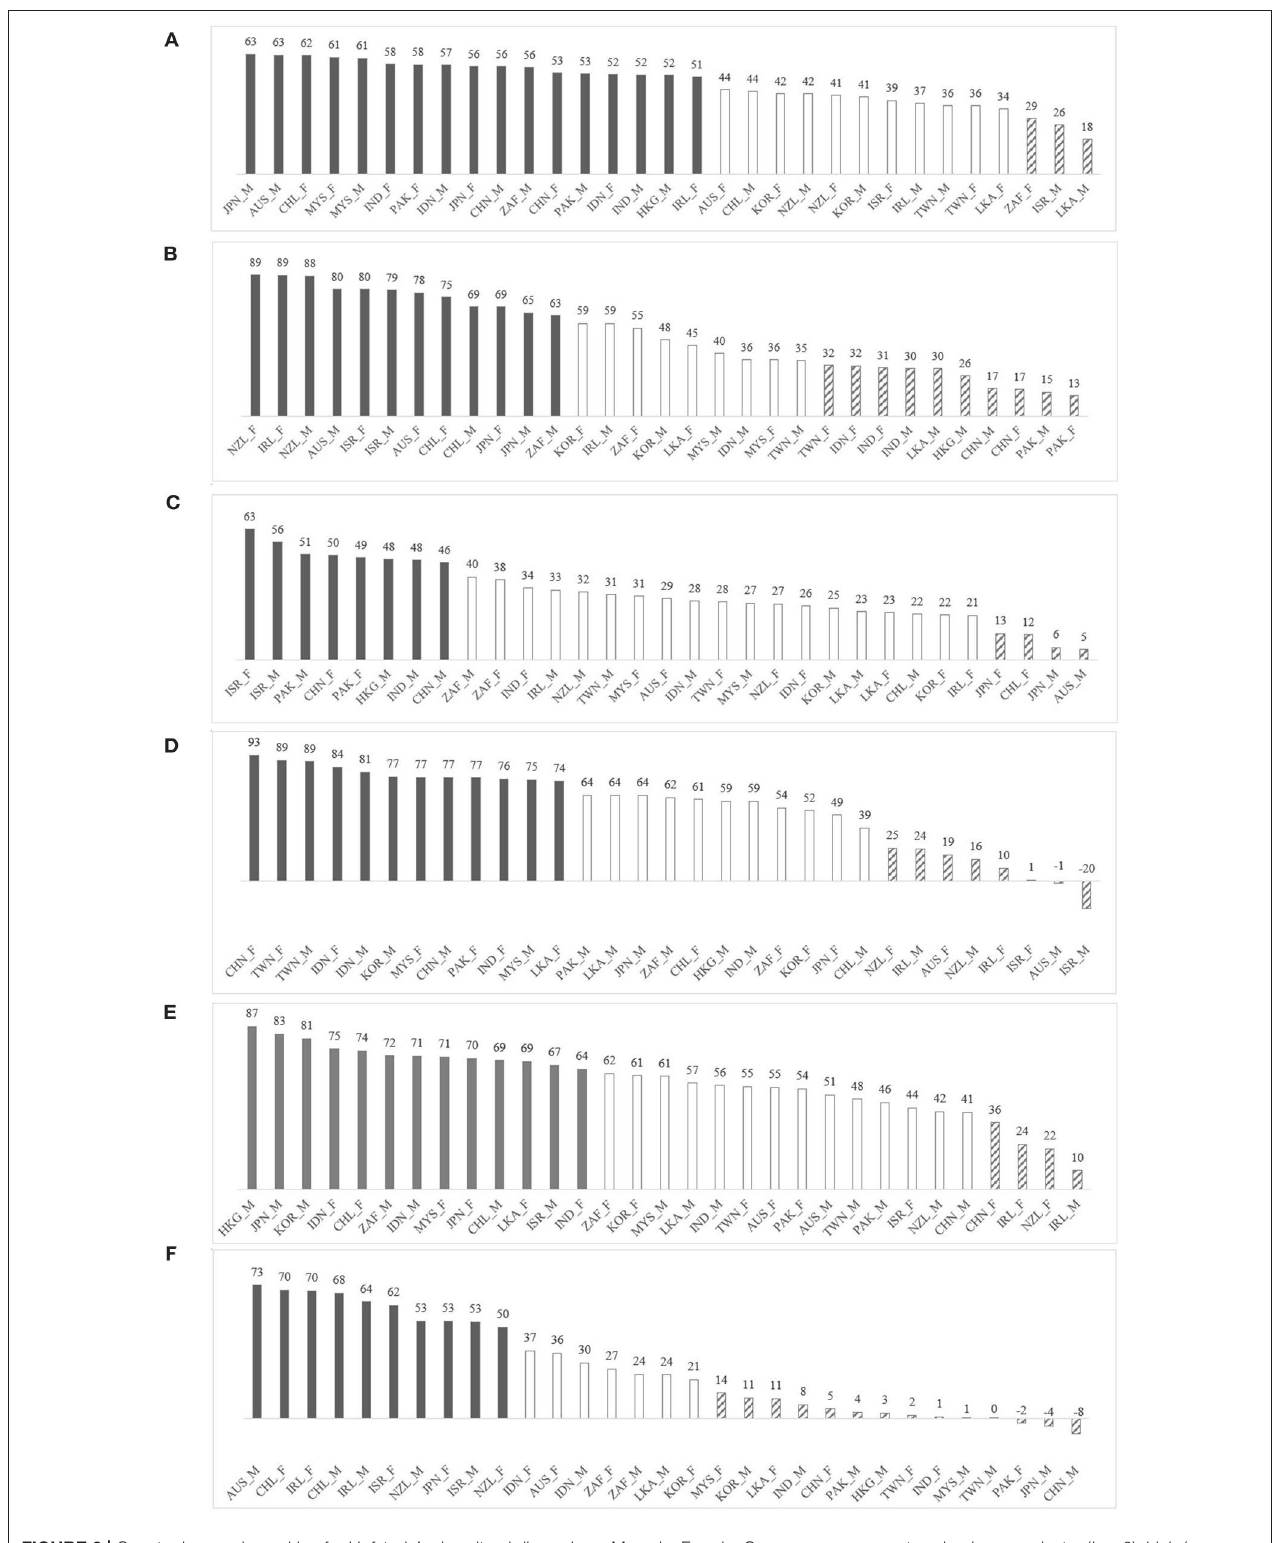
FIGURE 2 | Country-by-gender ranking for Hofstede’s six cultural dimensions: M, male; F, male. Groups were aggregate using k -mean cluster ( k = 3): high (gray bars), medium (white bars), and low (diagonal-stripe bars). (A) POWER , (B) INDIVIDUALISM , (C) MASCULINITY , (D) UNCERTAINTY , (E) ORIENTATION , and (F) INDULGENCE .